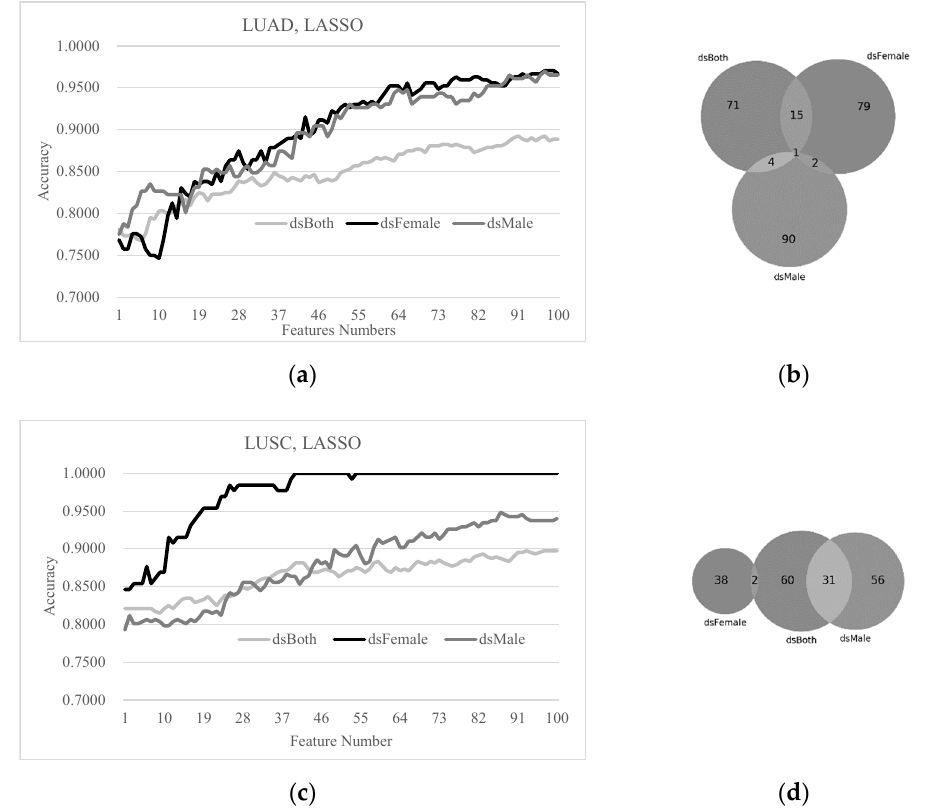
Figure 4. The SVM prediction performances and the sex disparities of the top-100 LASSO-ranked biomarkers. ( a ) The prediction performances of the classifier SVM and ( b ) the Venn plot of the LASSO-ranked biomarkers on the three models dsBoth, dsFemale and dsMale of the lung cancer subtype LUAD. ( c ) The prediction performances of the classifier SVM and ( d ) the Venn plot of the LASSO-ranked biomarkers on the three models dsBoth, dsFemale and dsMale of the lung cancer subtype LUSC.